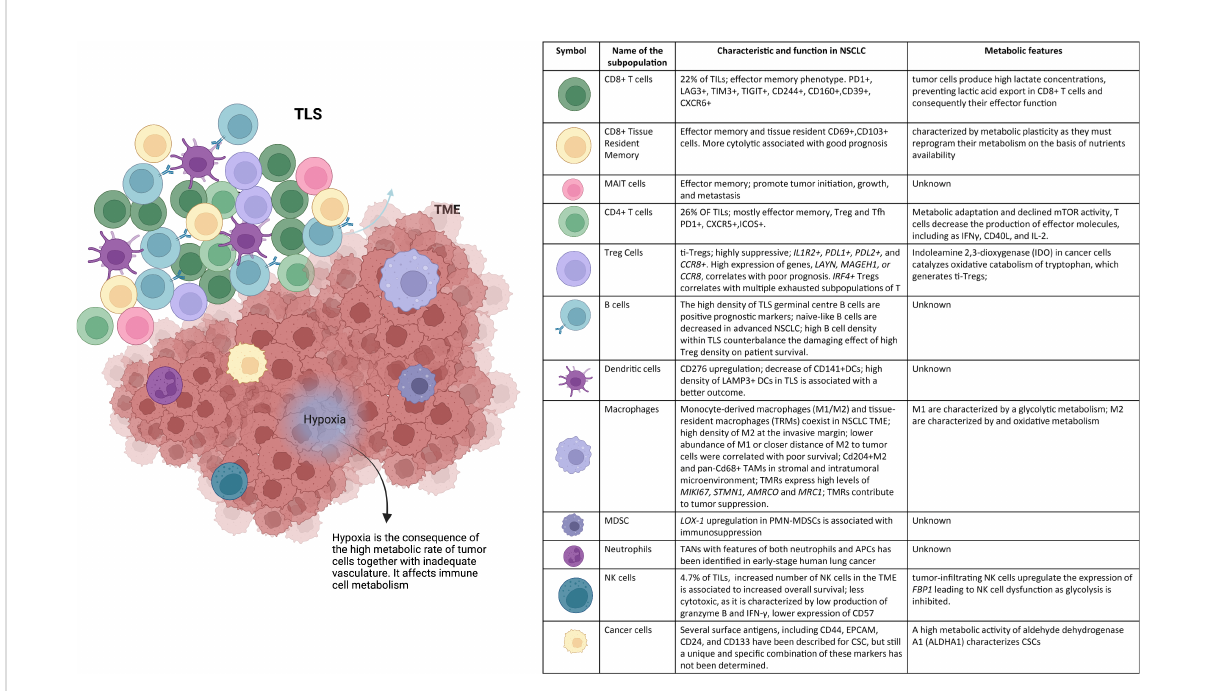
FIGURE 1 NSCLC microenvironment. The tumor niche is a dynamic structure in which tumor cells coexist with tumor vasculature, extracelluar matrix, and immune cells. The immune in fi ltrate includes multiple cell types, CD8 + T cells, CD4 + T cells, mucosal-associated invariant T (MAIT) cells, regulatory T (Treg) cells, B cells, NK cells, DCs, macrophages, MDSCs, and neutrophils. These cell subsets can have both pro- and anti-tumor functions and can vary in their activation status, their metabolism, and their localization within the tumor. Hypoxia drives changes in immune cell metabolism and functions. TLSs within the TME consist of T-cell areas containing DCs and B-cell areas with germinal centers. They represent critical sites where speci fi c T and B cells can undergo terminal differentiation into effector